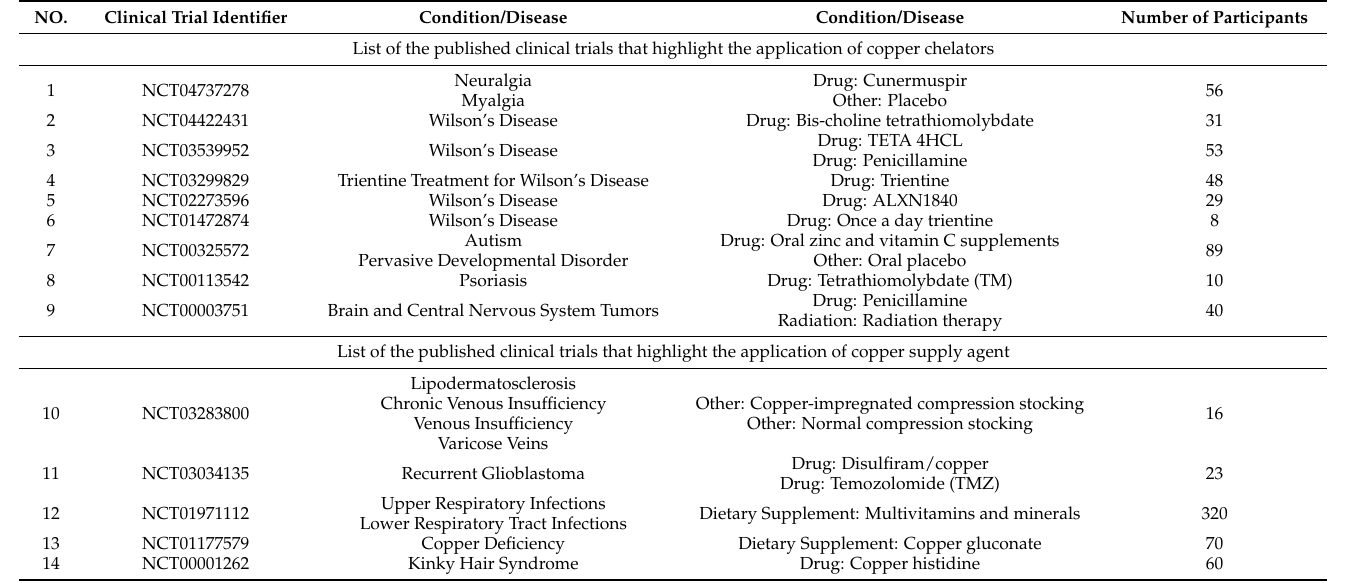
Table 1. List of the published clinical research of the drugs for